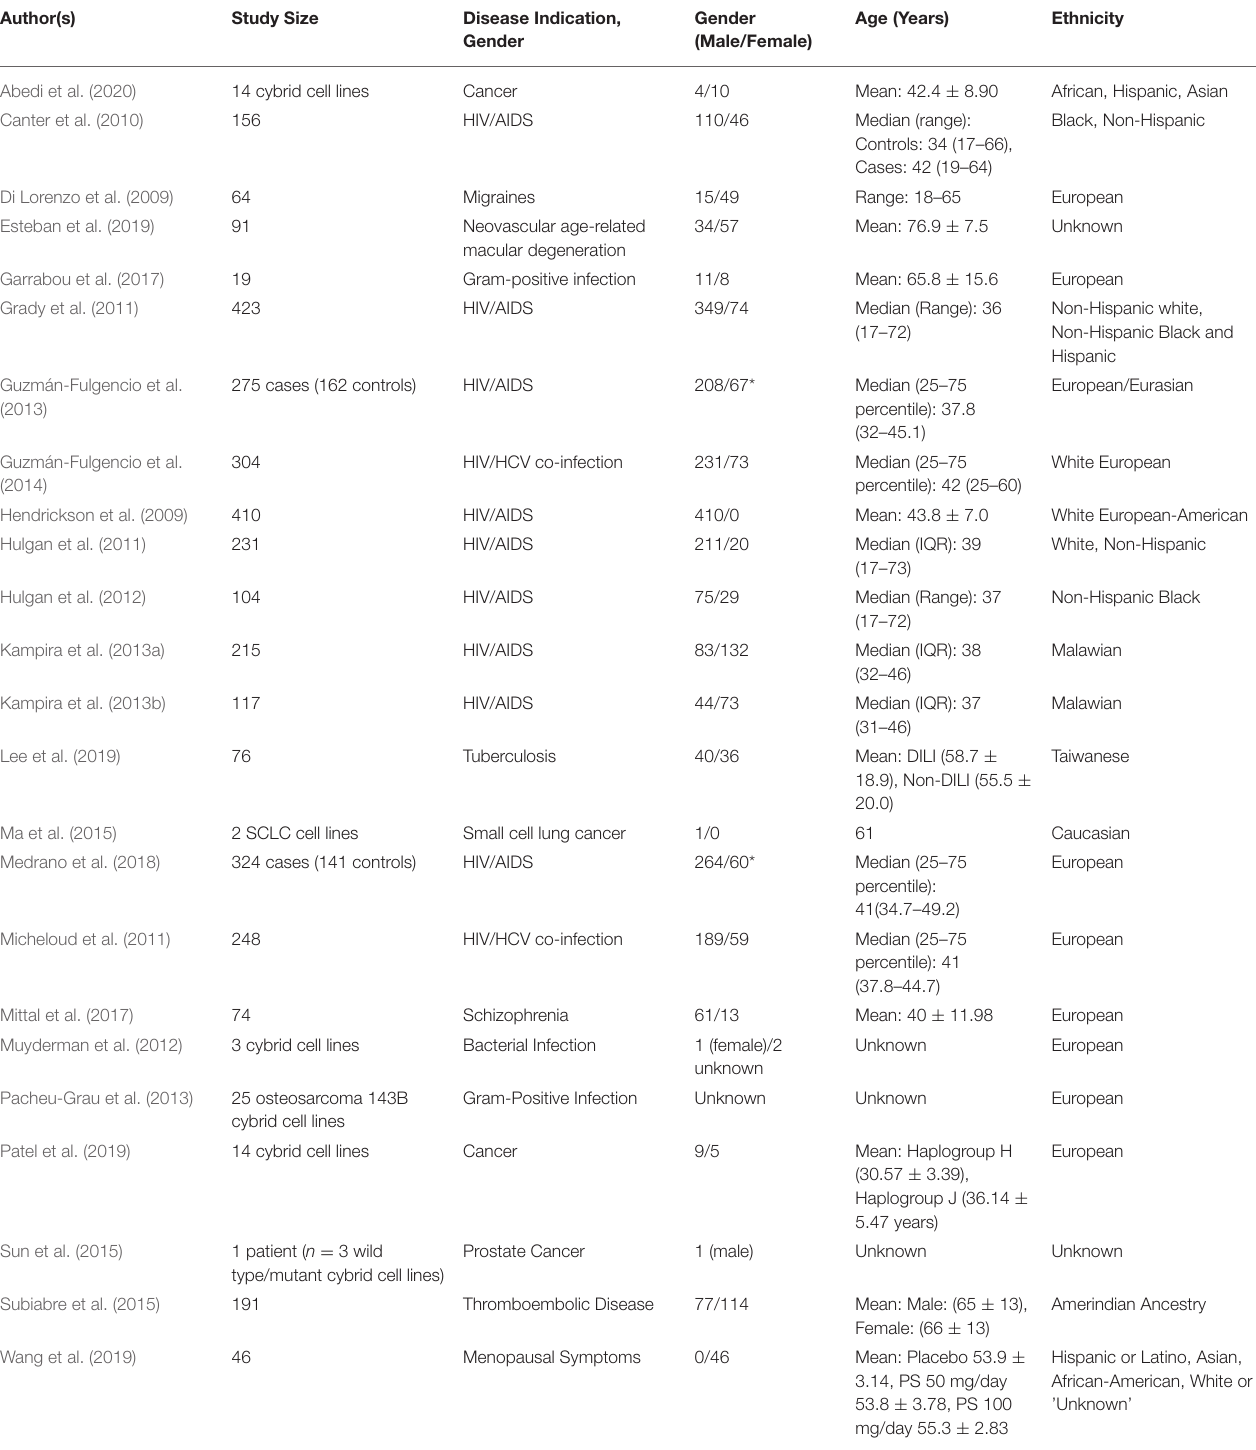
TABLE 3 | Summary of publications included in this review, including key demographic information extracted from each article: study size, disease indication, age distribution and ethnicity